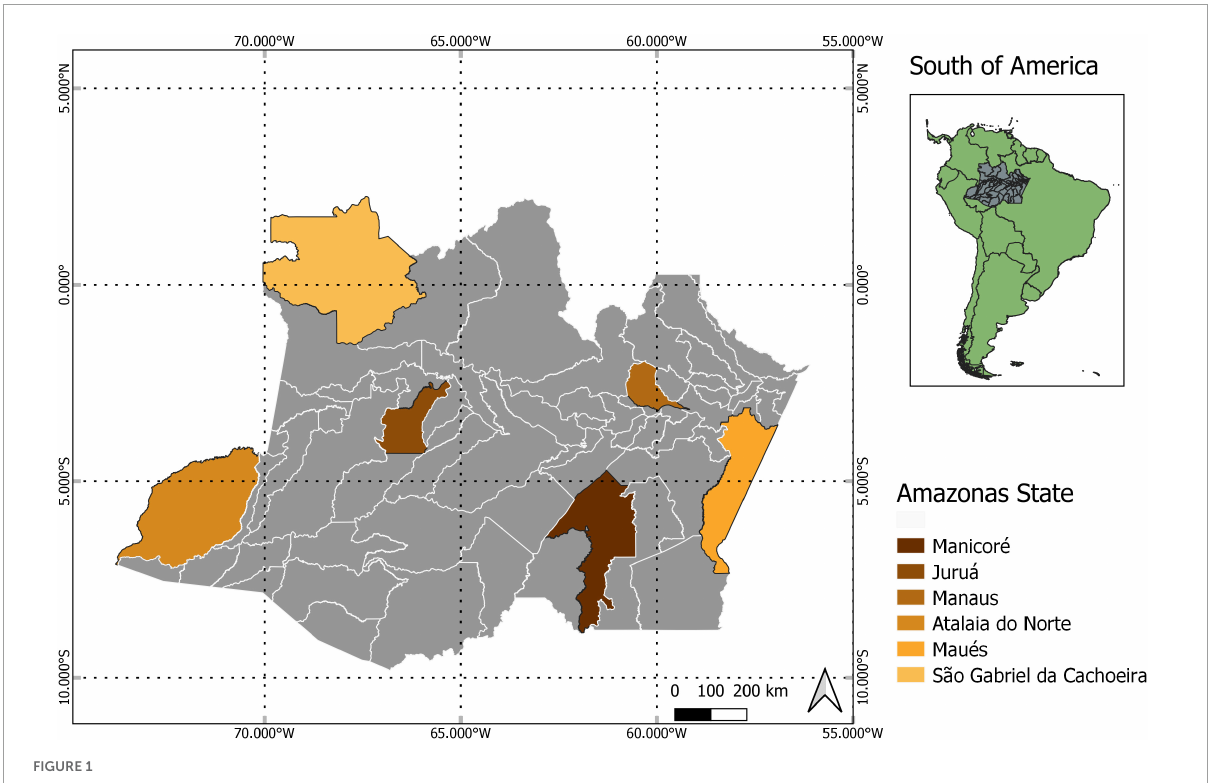
FIGURE1 Map showing the locations of the study